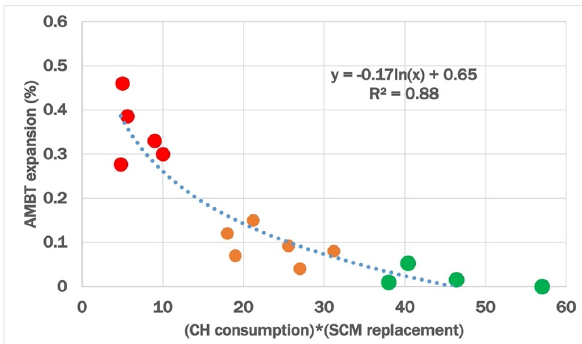
Figure 6. Accelerated mortar bar test expansion at 14 ‐ days plotted as a function of SCM calcium hydroxide consumption multiplied by SCM replacement in mortars (unpublished